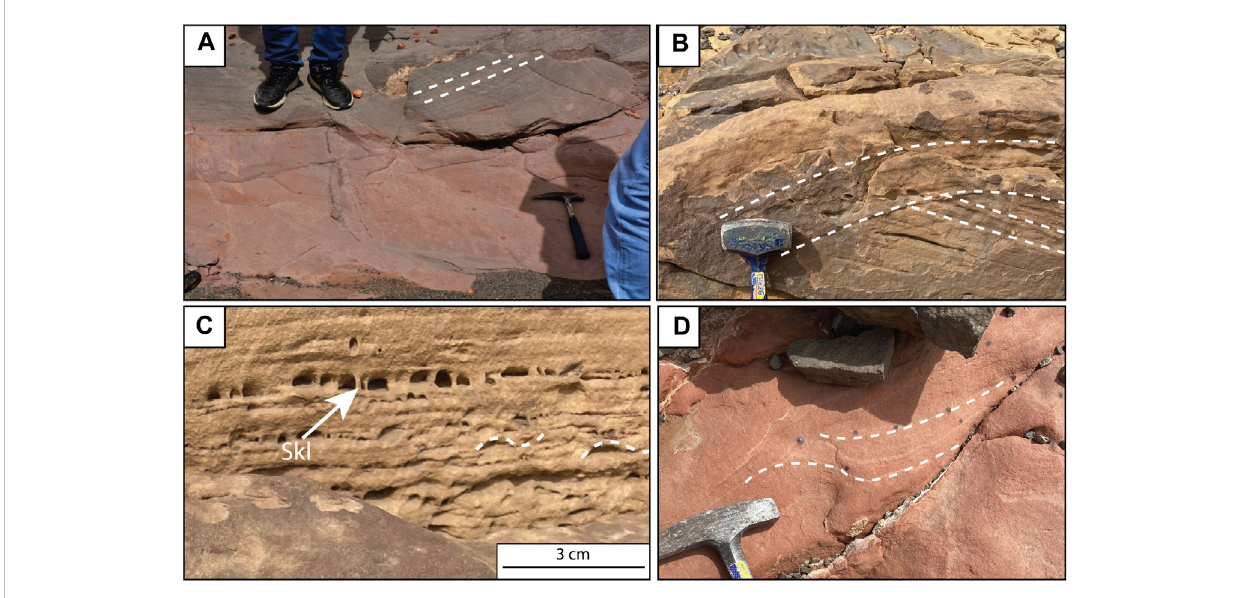
FIGURE 6 Close-up view of the established depositional facies. (A) Parallel-laminated siltstone. (B) Hummocky cross-strati fi ed sandstone. (C) Wave-rippled sandstones with evidence of biotubations by Skolithos (Skl). (D) Trough cross-bedded